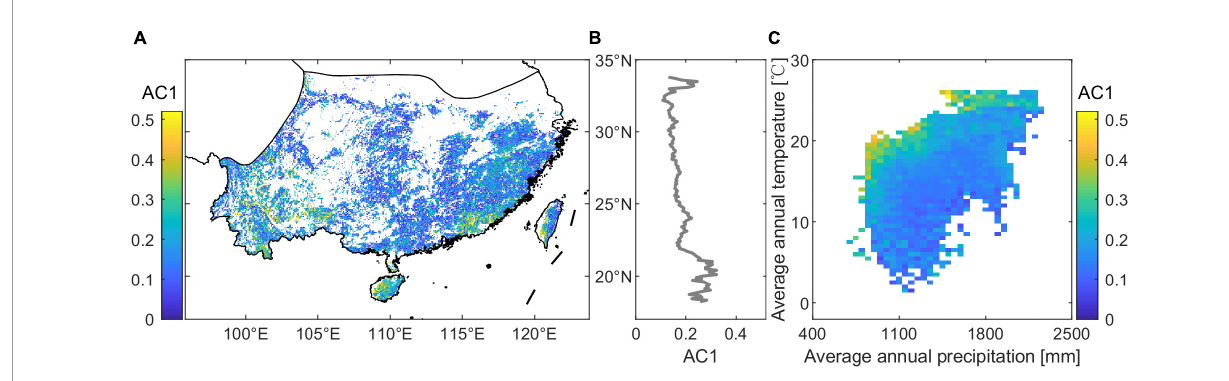
FIGURE2 Spatial variation in the resilience of subtropical evergreen forests in China. (A) Spatial map of long-term lag-one autocorrelation (AC1) computed from kNDVI data for the whole 2001–2020 period. (B) Long-term AC1 with latitude. (C) Long-term AC1 binned as a function of precipitation and temperature.